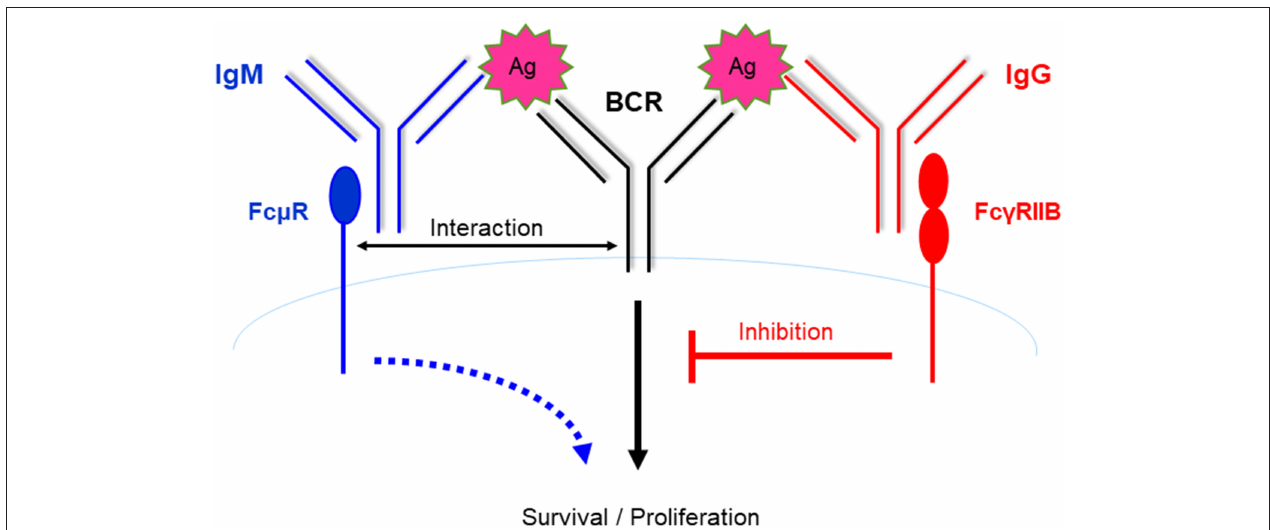
FIGURE 1 | B cells express two types of Fc receptors of opposing functions. Fc µ R promotes B cell activation via interacting with the BCR and potentiating BCR signaling. In contrast, B cells express Fc γ RIIB, which inhibits B cell activation upon binding to immune complexes containing IgG and the cognate Ag, which then results in colligation of Fc γ RIIB and the BCR. Therefore, B cells express two types of Fc receptors of opposing functions. It is suggested that these two receptors function in a spatial-temporal manner to positively and negatively regulate B cell activation during humoral immune responses (see Figure 2 ).